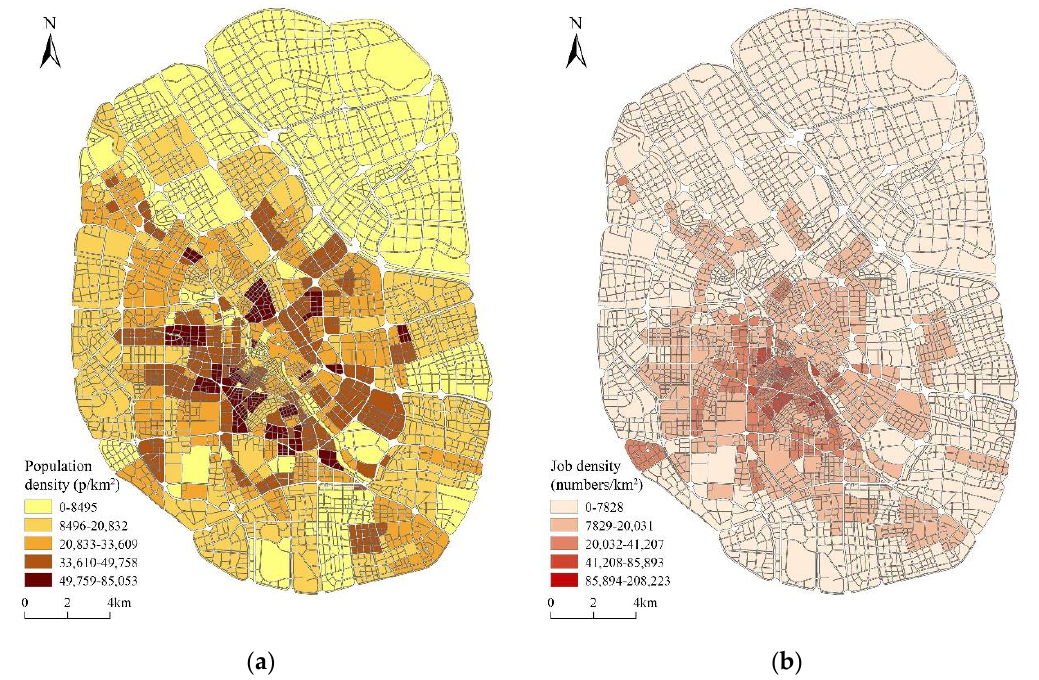
Figure 3. ( a ) Population density in Tianjin central area; ( b ) Job density in Tianjin central area.